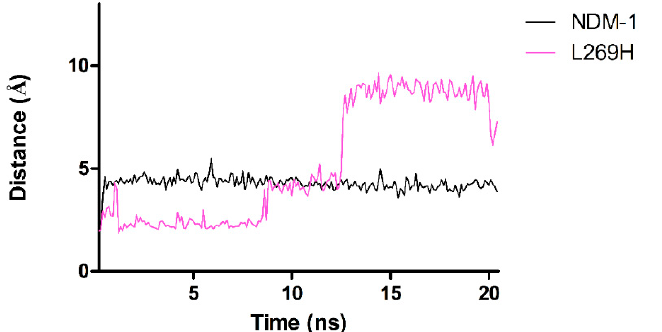
Figure 2. Evolution of the distances between Zn2 and H250 in NDM-1 and L269H mutant. Here, Zn2-H250 coordination is lost from 12.3 ns with a shift of about 3.5 A in comparison to NDM-1. Differences in the distances for Zn2-D124 were observed in L218T, L221T and L221T/Y229W enzymes. In these mutants, D124 was closer to Zn2 (Table 4). The pKa values, collected each 2 ns during the production run, were determined for all “first sphere” coordination residues in NDM-1 and its mutants (Figure 3). The L218T and L269H replacements in the NDM-1 structure caused a substantial alteration of pKa values in C208 and H250, in which a decrease of basic and acid behavior, respectively, was observed. In L269H mutant residue, H120 lost its strong acidic feature.